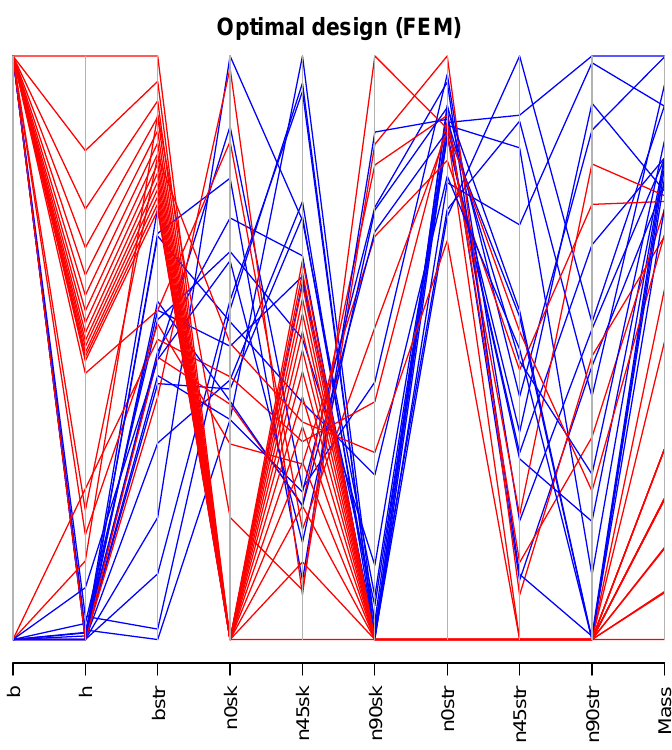
Figure 20. First DOE: parallel coordinate values of optimal feasible (blue) and infeasible (red) designs.